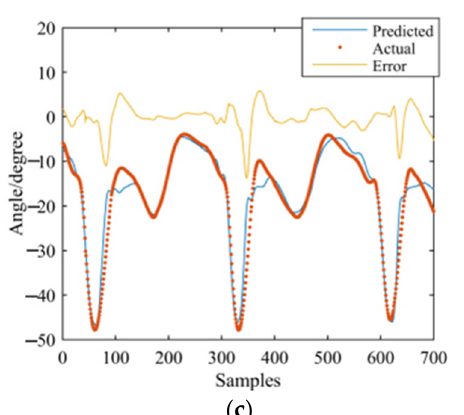
Figure 14. Prediction results of knee-joint angle in the going upstairs process. ( a ) Results of IN1; ( b ) Results of IN2; ( c ) Results of IN3.